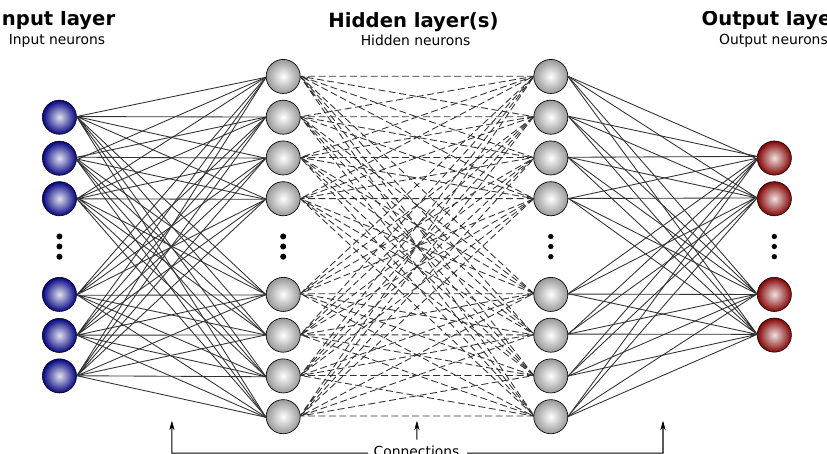
Figure 1. Generic structure of a multilayer perceptron (MLP), a form of a feed-forward artificial neural network used in this